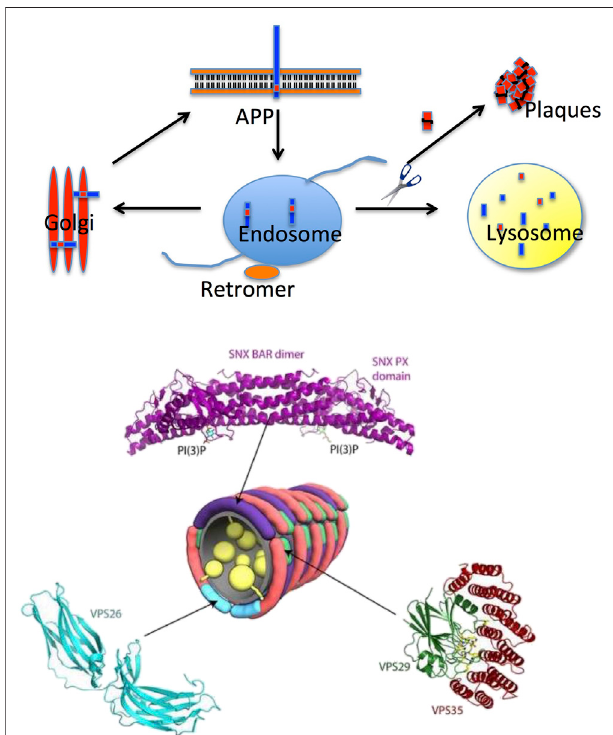
FIGURE 2 | Intracellular protein traf fi cking and the retromer. Top panel : theretromerispartoftheendosome,thehubinintracellularproteintraf fi cking; retromer ’ sroleistotransferproteinstotheGolgiapparatusortothelysosome for proteolysis. Retromer ’ s dysfunction in Alzheimer ’ s disease causes improper sorting of APP (the amyloid precursor protein) with accumulation of A β 40/42andeventuallyplaqueformation(inspiredbyaschemesuggestedby Prof. G Petsko, New York, USA, reproduced with permission). Bottom panel : structural organization of the retromer. The crystal structure of human VPS6A is shown in cyan (PDB 2FAU), and those of human VPS29 and VPS35 are shown in green and red, respectively (PDB 2R17). Residues surrounding the inactivemetallophosphoesterasesite ofVP29are shown inastickmodel. The structureoftheSNXdimer isrepresented inpurple(AdaptedfromBrunoriand Gianni (2016); reported with